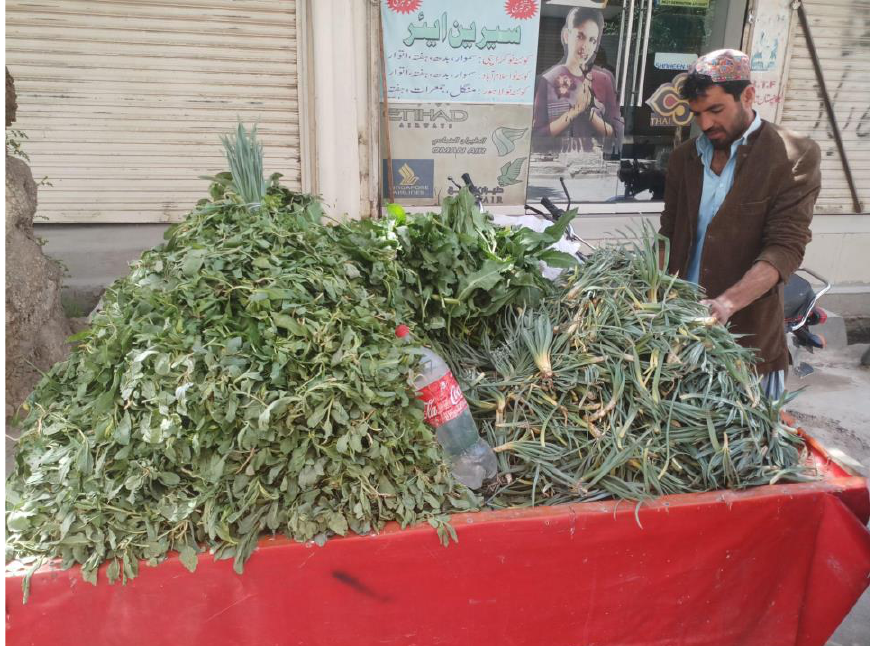
Figure 2. Wild food plants ( Arum spp. in the middle upper part of the picture and Gundelia tourne- fortii in the bottom) sold in a local market in Kurdistan (Photo: Ahmed H.M.).